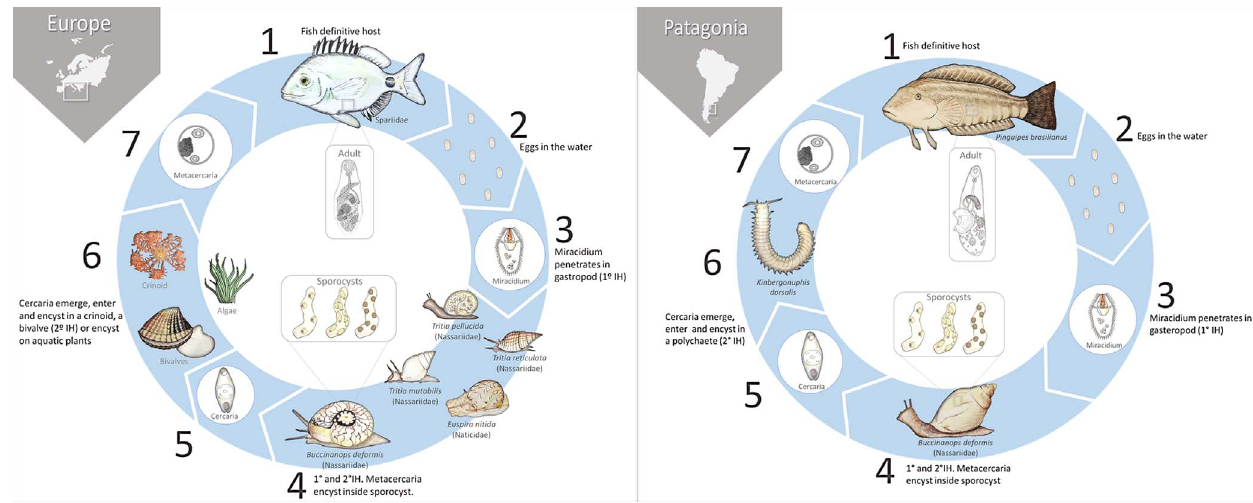
Figure 2. Schematic diagram of the known life cycles of the digenetic zoogonids Diphterostomum brusinae from Europe and Diphterostomum fl avum n. sp. from Patagonia (South America). Abbreviations : IH, intermediate host. References: [21, 25, 54, 55, 60, 62]. Table 1. List of invertebrates and fi sh dissected for developmental stages of Diphterostomum fl avum n. sp. from the Patagonian coast, Argentina. Localities: FB, Fracasso Beach (San José Gulf) (42 (cid:3) 25 0 43 00 S, 64 (cid:3) 07 0 46 00 W); CB, Cracker Bay (Nuevo Gulf) (42 (cid:3) 51 0 33 00 S, 64 (cid:3) 46 0 16 00 W); PE, Punta Este (Nuevo Gulf) (42 (cid:3) 47 0 13 00 S, 64 (cid:3) 56 0 49 00 W); PM, Puerto Madryn (Nuevo Gulf) (42 (cid:3) 46 0 S, 64 (cid:3) 54 0 W); PL,